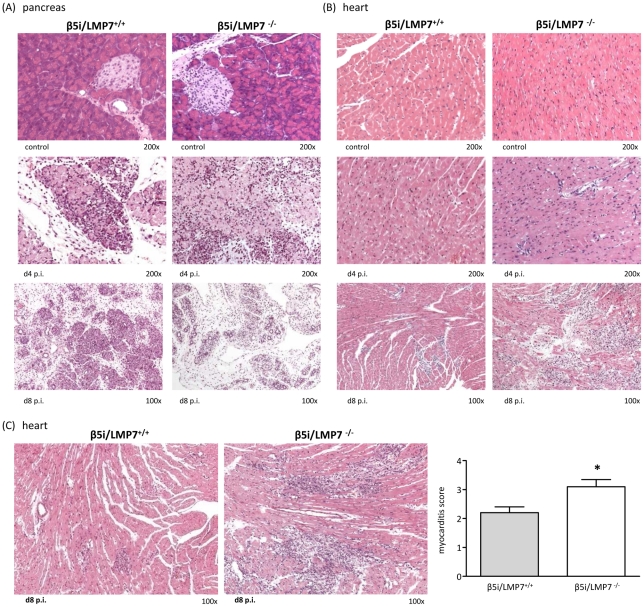
Severe acute CVB3-myocarditis in IP-deficient mice.Representative hematoxylin-eosin (HE)-staining are illustrated from (A) the pancreas and (B) the heart of β5i/LMP7+/+ and β5i/LMP7-/- mice at different time points p.i. revealing severe acute myocarditis in β5i/LMP7-/- mice at d8 p.i. All cardiac and pancreatic tissue sections shown are representative for at least n = 10 mice/group. (C) Tissue sections from a different experiment confirmed severe heart muscle injury in β5i/LMP7-/- mice at d8 p.i. (enlarged image). To quantify myocardial damage comprising cardiac cell necrosis, inflammation, and scarring, a myocarditis score from 0 to 4 was applied (0: no inflammatory infiltrates, 1: small foci of inflammatory cells between myocytes, 2: larger foci of >100 inflammatory cells, 3: ≤10% of cross-section involved, 4: 10 to 30% of a cross-section involved) [50] (* p<0.05; mean from n = 5 mice).